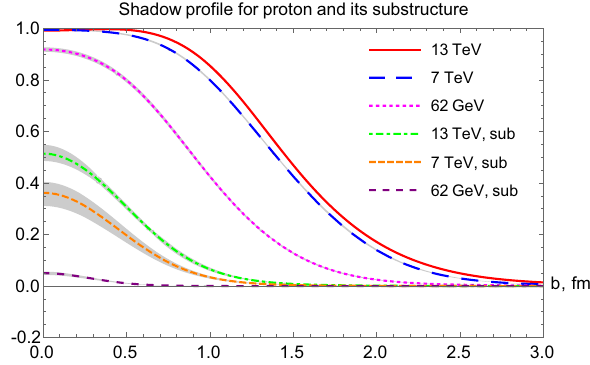
inelasticity profiles of the proton and its substructure at dif- √ s = 13 TeV, 7 TeV and 62 GeV is illustrated in Fig. 3 ferent together with